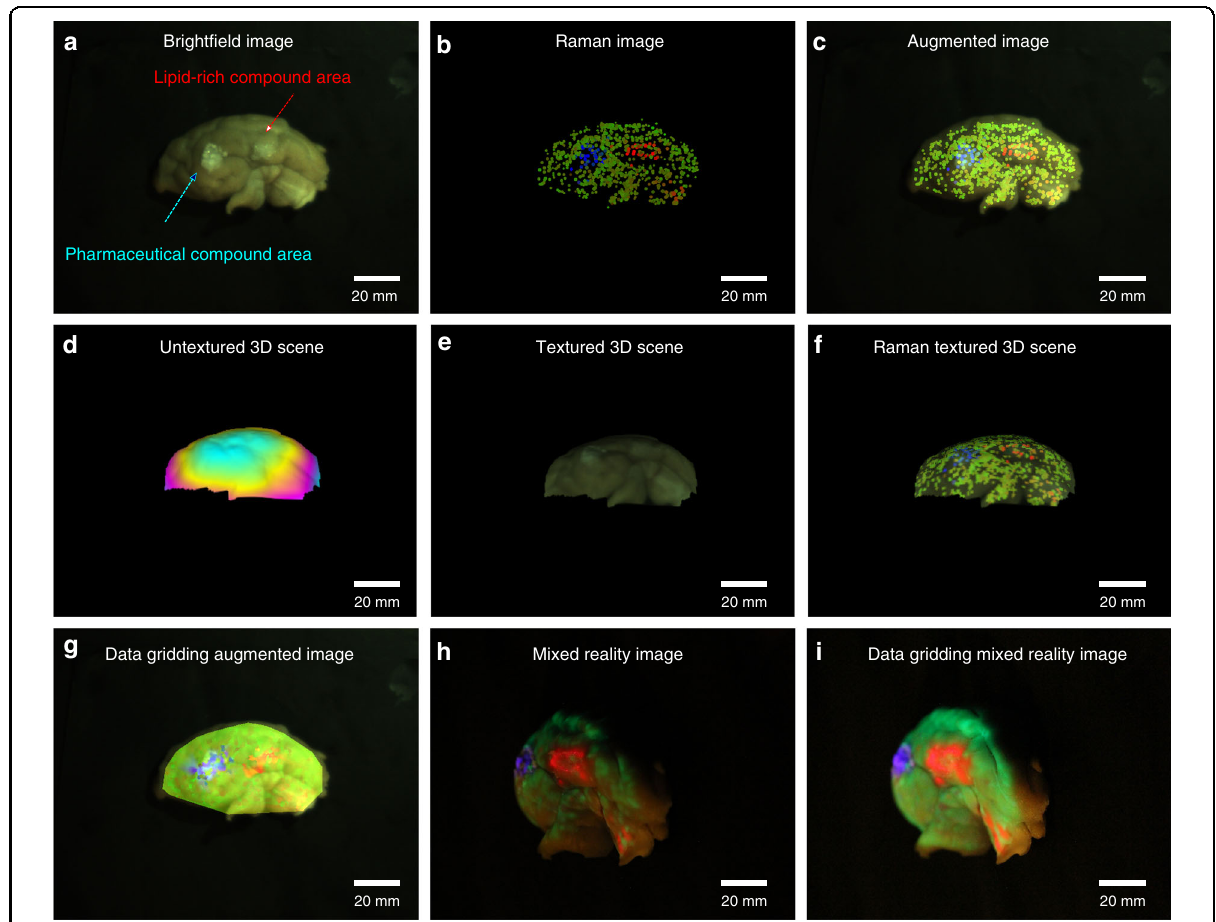
Fig. 1 Representative results of the proposed approach on a porcine brain sample. a Bright fi eld image of the sample, where the arrows indicate areas with a lipid-rich and pharmaceutical compound. In the bright fi eld image it is not only challenging to localize the regions but does not provide any possibility to differentiate between regions. b Reconstructed Raman image provides the molecular distribution on the sample. c Augmented reality image directly combines the molecular information with the bright fi eld scene, readily providing a differentiation between the regions. d The reconstructed untextured height 3D scene image of the sample employing photometric stereo and e as textured 3D image with the original bright fi eld image. f The height 3D scene image textured with the reconstructed Raman image, which now not only enables the two dimensional, but three dimensional visualization of the augmented molecular information. g Raman image after data gridding of the molecular data, forming a fully fi lled 3D augmented molecular image. h Improved and direct visualization of the mixed Raman reality image is back-projected onto the sample, so that the molecular boundaries are visible to the user. i Presents the results as in h , but with gridded data, which allows to better visualize molecular boundaries. The color information in all fi gures represent the different chemical components, i.e., red for the lipid-rich compound, green for gray matter on the cerebrum, and blue for the pharmaceutical